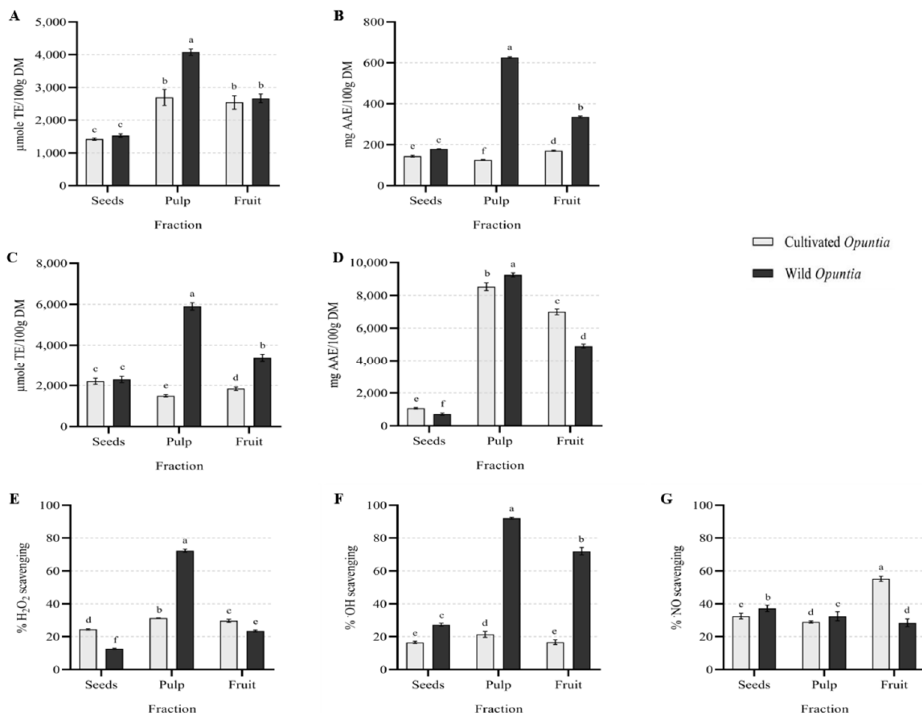
Figure 4. Antioxidant potential of different Opuntia sp. fractions. ( A ) Trolox equivalent antioxidant capacity; ( B ) Reducing power; ( C ) Ferric reducing antioxidant power; ( D ) Phosphomolybdenum antioxidant activity; ( E ) Hydrogen peroxide scavenging activity; ( F ) Hydroxyl radical inhibition assay; ( G ) Nitric oxide radical scavenging assay. TE, Trolox Equivalents; AAE, Ascorbic Acid Equivalents; H 2 O 2 , Hydrogen Peroxide; • OH, Hydroxyl Radical; • NO, Nitric Oxide Radical; DM, Dry Matter. Results are expressed as mean ± SD corresponding to the maximum percentage of inhibition of Opuntia sp. extracts, determined by at least five independent assays. Significant differences between the samples were designed with different letters from the most significant (letter a) to the lowest significant (letter f) ( p ≤ 0.05,